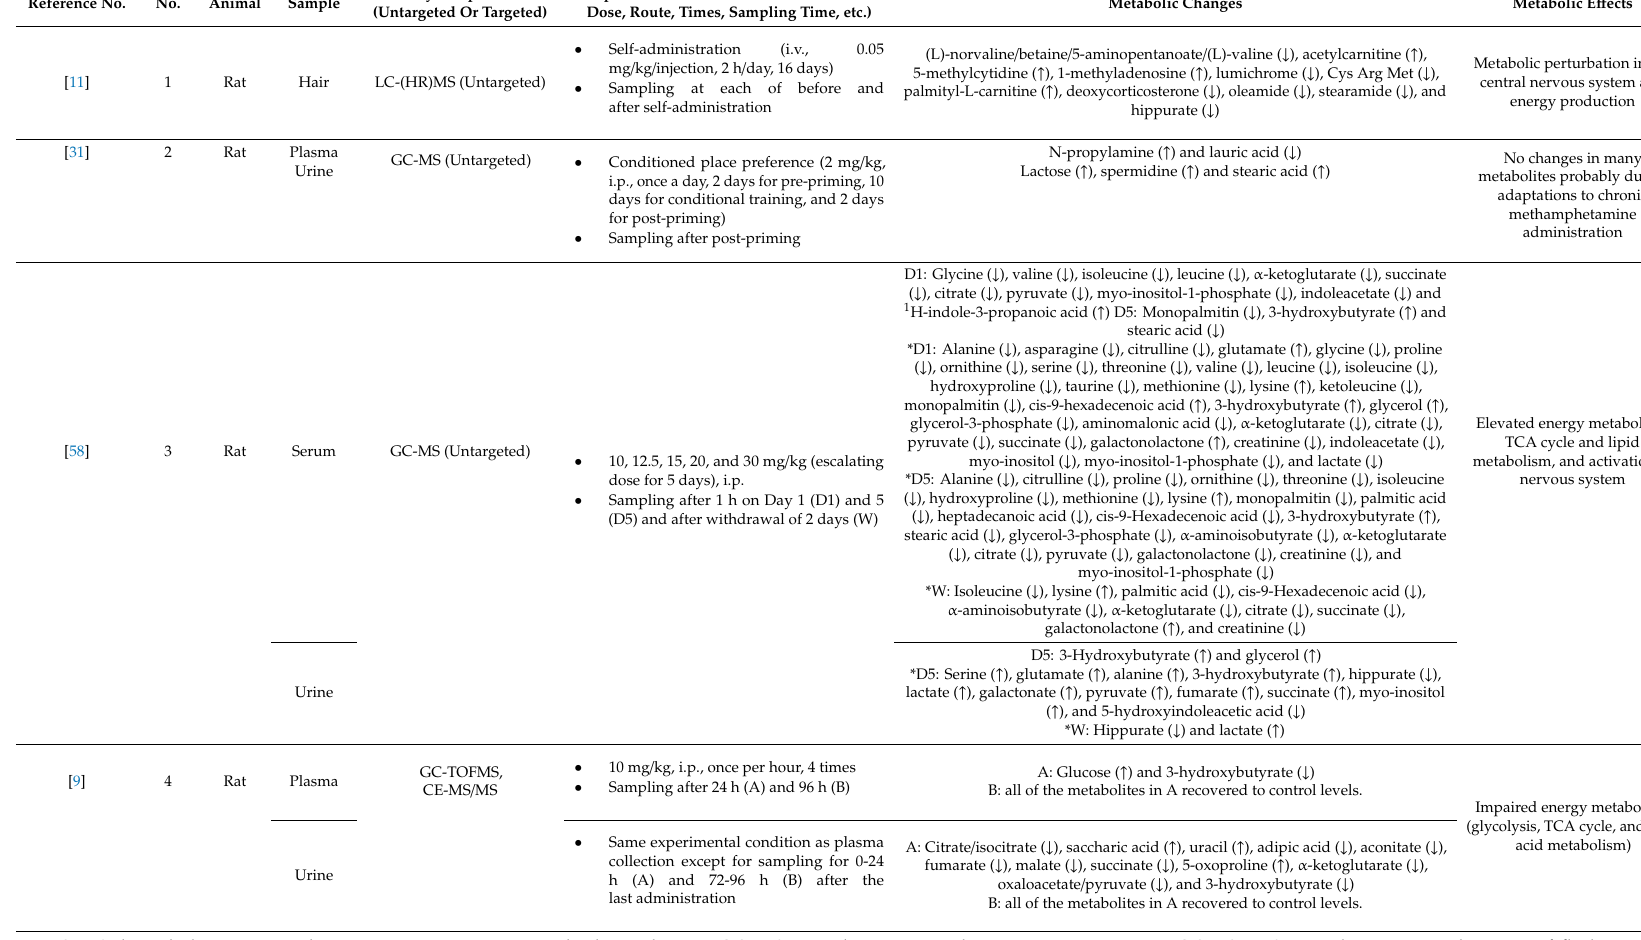
LC-MS, liquid chromatography-mass spectrometry; HR, high resolution; GC-MS, gas chromatography mass spectrometry; GC-TOFMS, gas chromatography-time-of-flight mass spectrometry; CE-MS / MS, capillary electrophoresis-tandem mass spectrometry; i.p., intraperitoneal injection; ↓ , significantly decreased vs. vehicle group, except for *; ↑ , ↓ , significantly decreased vs. vehicle group except for *; *vs. pre-administration